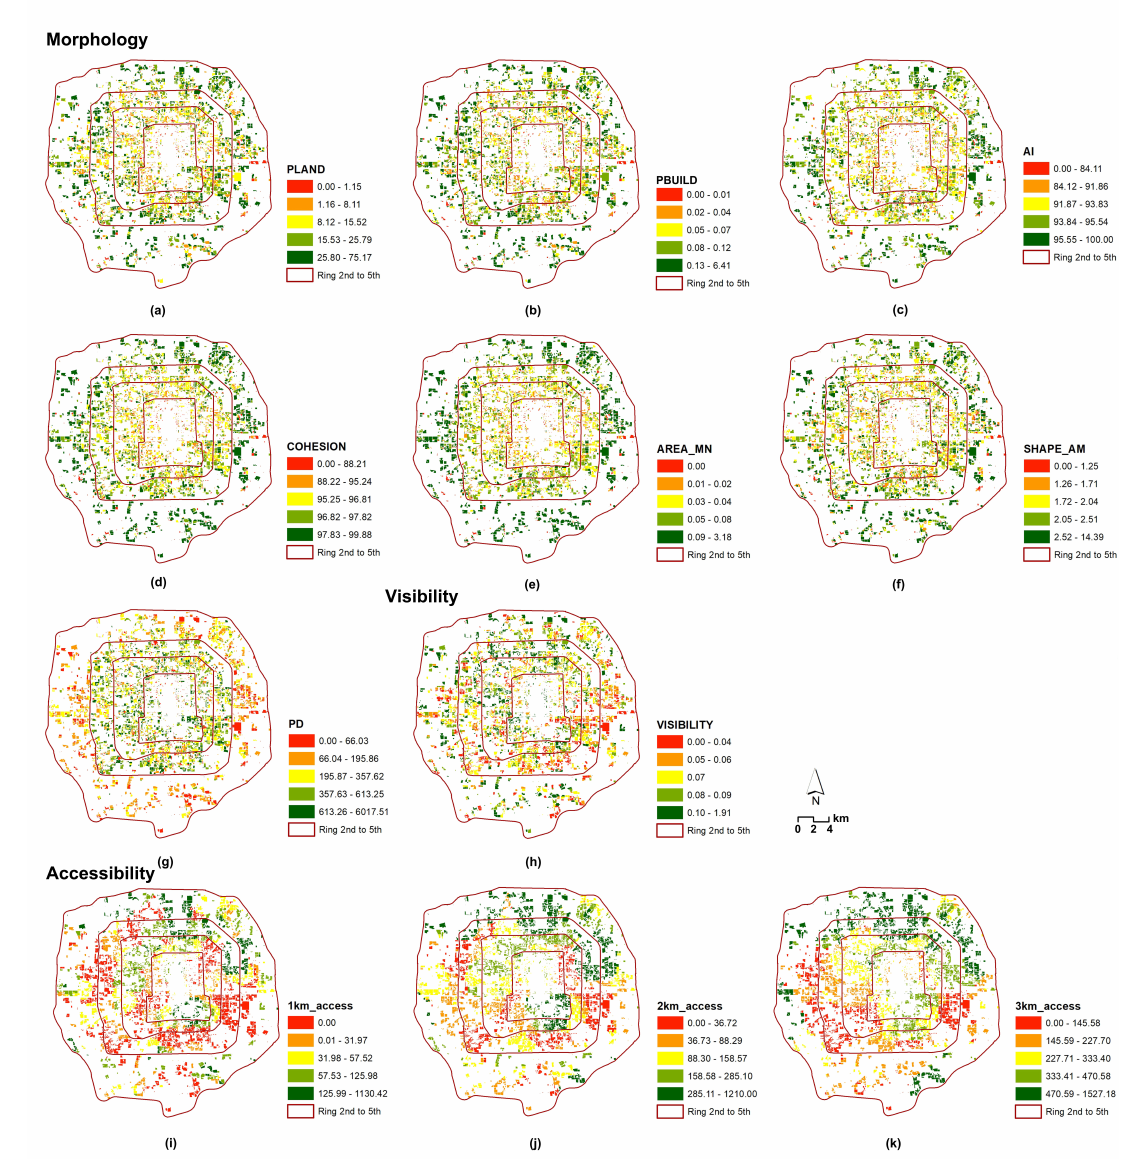
Figure 4. Measurement results of 11 green equity metrics for residential communities within the 5th ring of Beijing, in terms of morphology ( a – f ), visibility ( g , h ) and accessibility ( i – k